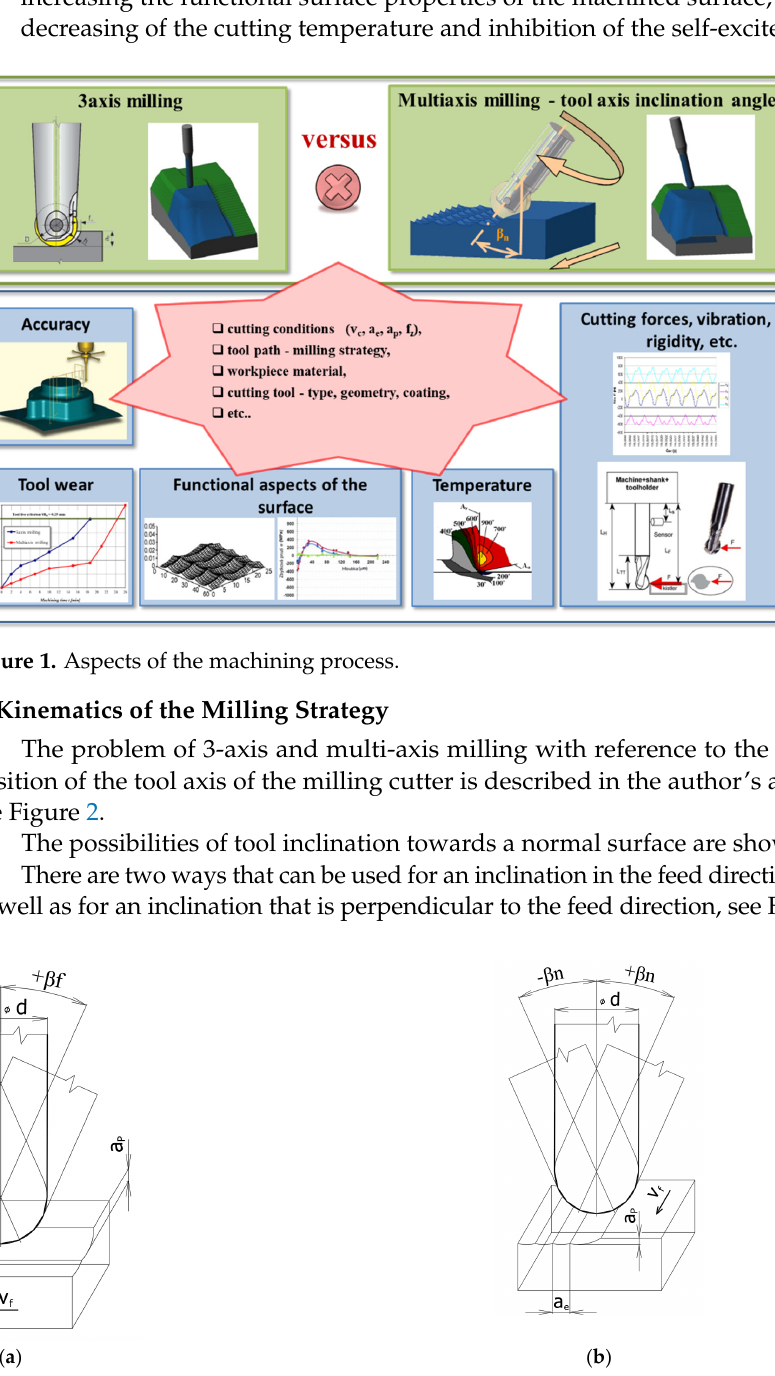
Figure 2. The possibilities of the milling strategy with a tool axis inclination angle [2,14]. ( a ) Tilt in feed direction, ( b ) tilt in pick feed direction (d—tool diameter, a p —axial depth of cut, a e —radial depth of cut, v f —feed direction, β f—tool axis inclination angle in the feed direction, β n—tool axis inclination angle in the pick feed direction.